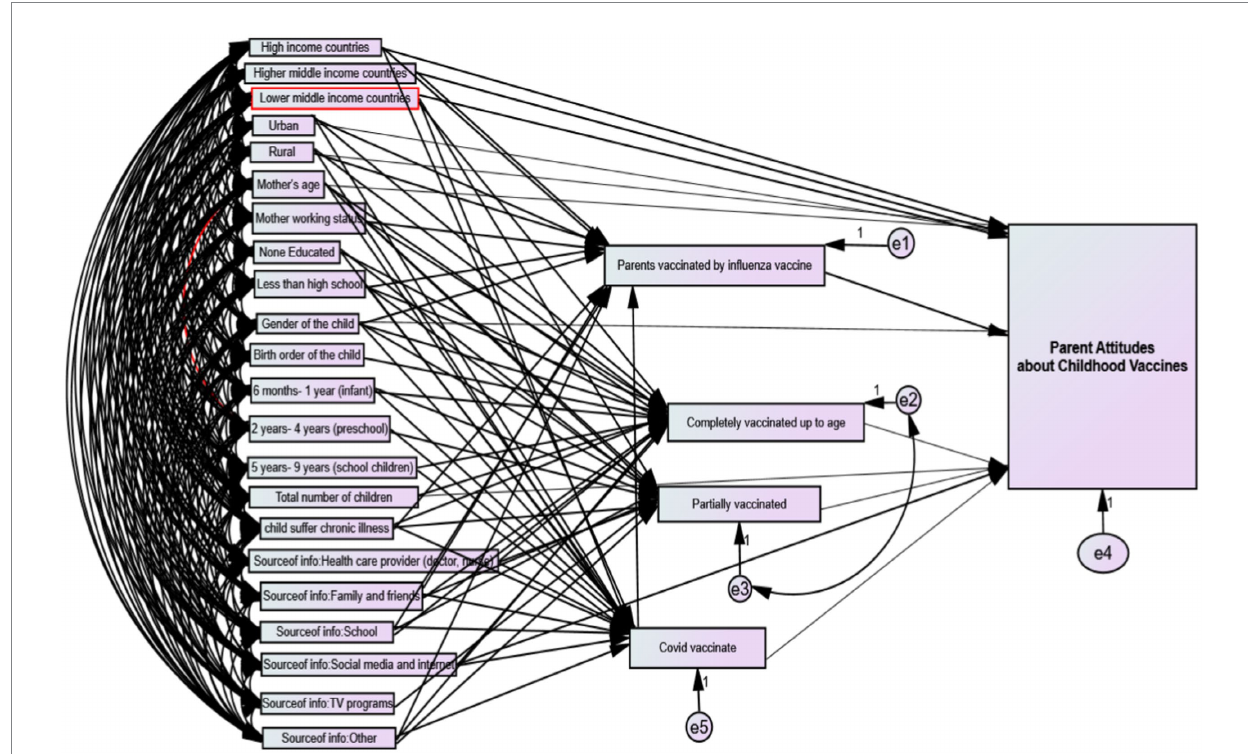
FIGURE 2 Visualization of the structural equations model for parental attitude toward childhood influenza vaccines.